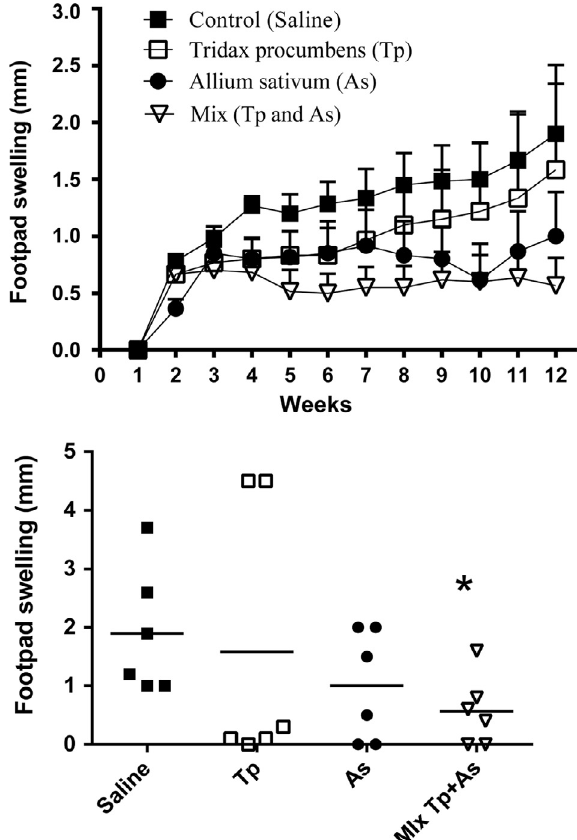
Figure 1. Footpad swelling in CD-1 mice after two weeks of infection with 1 · 10 6 L. mexicana promastigotes. Top: four groups of mice were treated either with saline, T. procumbens extract, A. sativum extract or the mixture of T. procumbens and A. sativum extracts. the treatments were applied i.p. daily for two weeks. Bottom: the footpad thickness was measured and compared to the noninoculated footpad for each mouse for 12 weeks. Each point represents the average increase of the infected footpad thickness, standard error ( n = 6). Comparison of four experimental groups in 12 weeks after infection, each symbol represents each mouse of the group, the horizontal line represents the mean, and * indicates significant differences with the PBS-treatment control group (unpaired t -test, p <